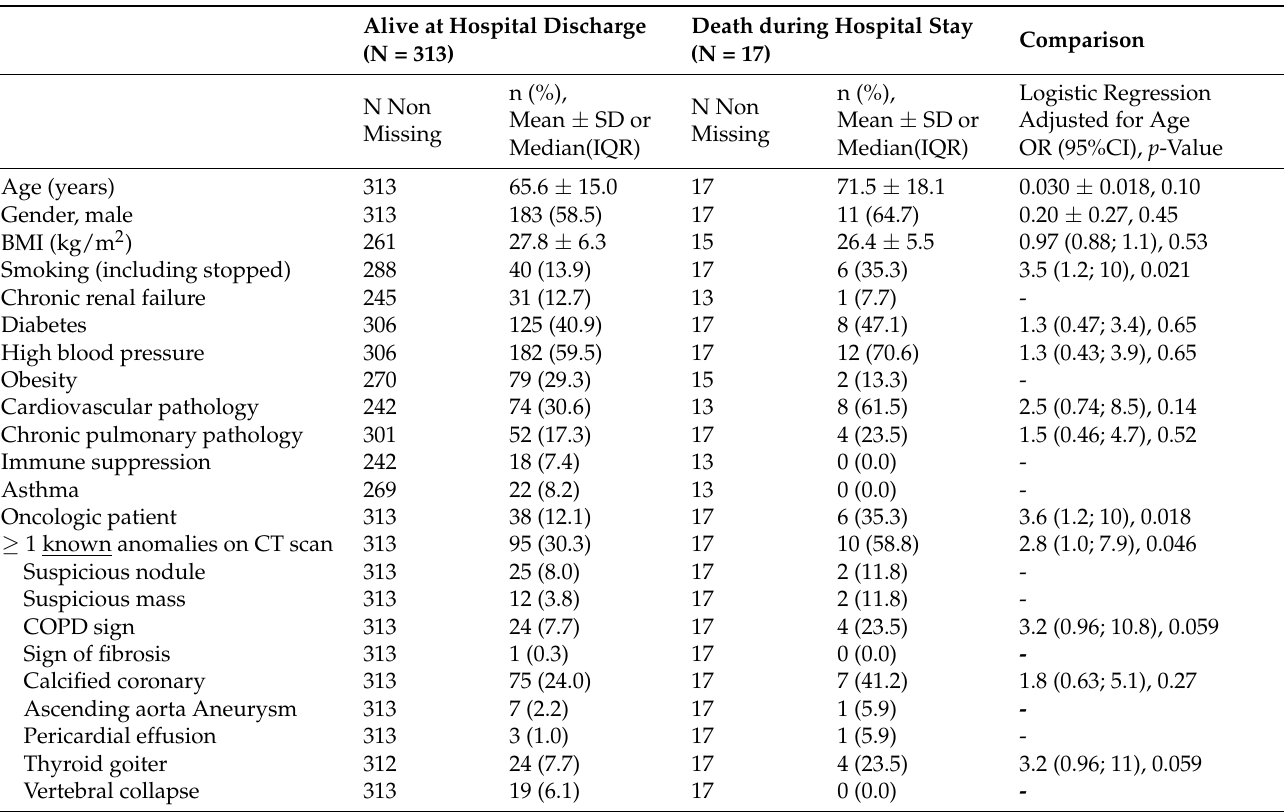
Table A3. Impact of patients’ characteristics on the risk of death during hospital stay (N = 330 COVID-19-hospitalized